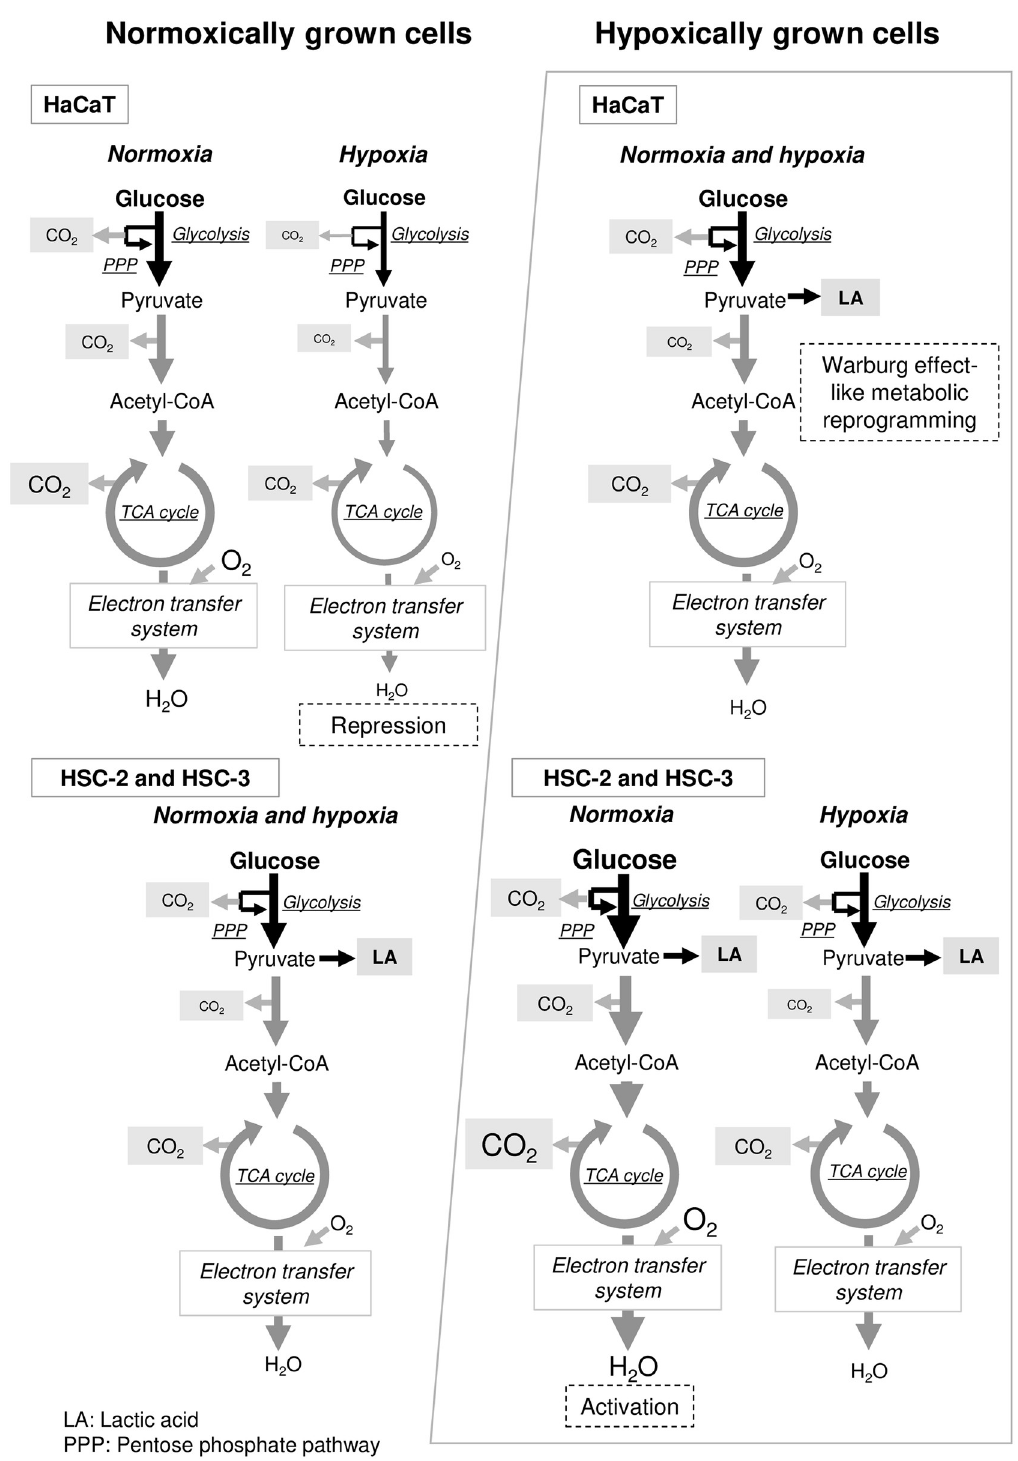
Fig 6. Schematic diagram showing the metabolic effects of the environmental oxygen concentration revealed in the present study.